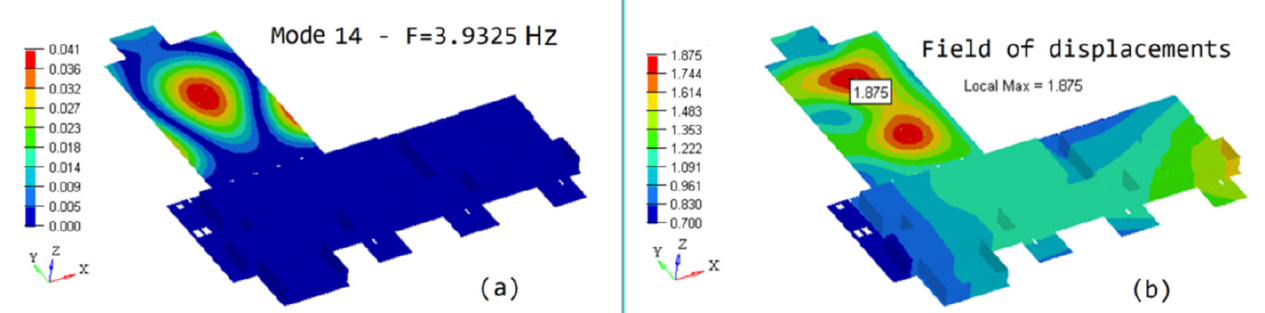
Figure 8. ( a ) Eigenmode 14; ( b ) distribution of transmissibility in different points to a harmonic excitation with the 14th eigenfrequency.